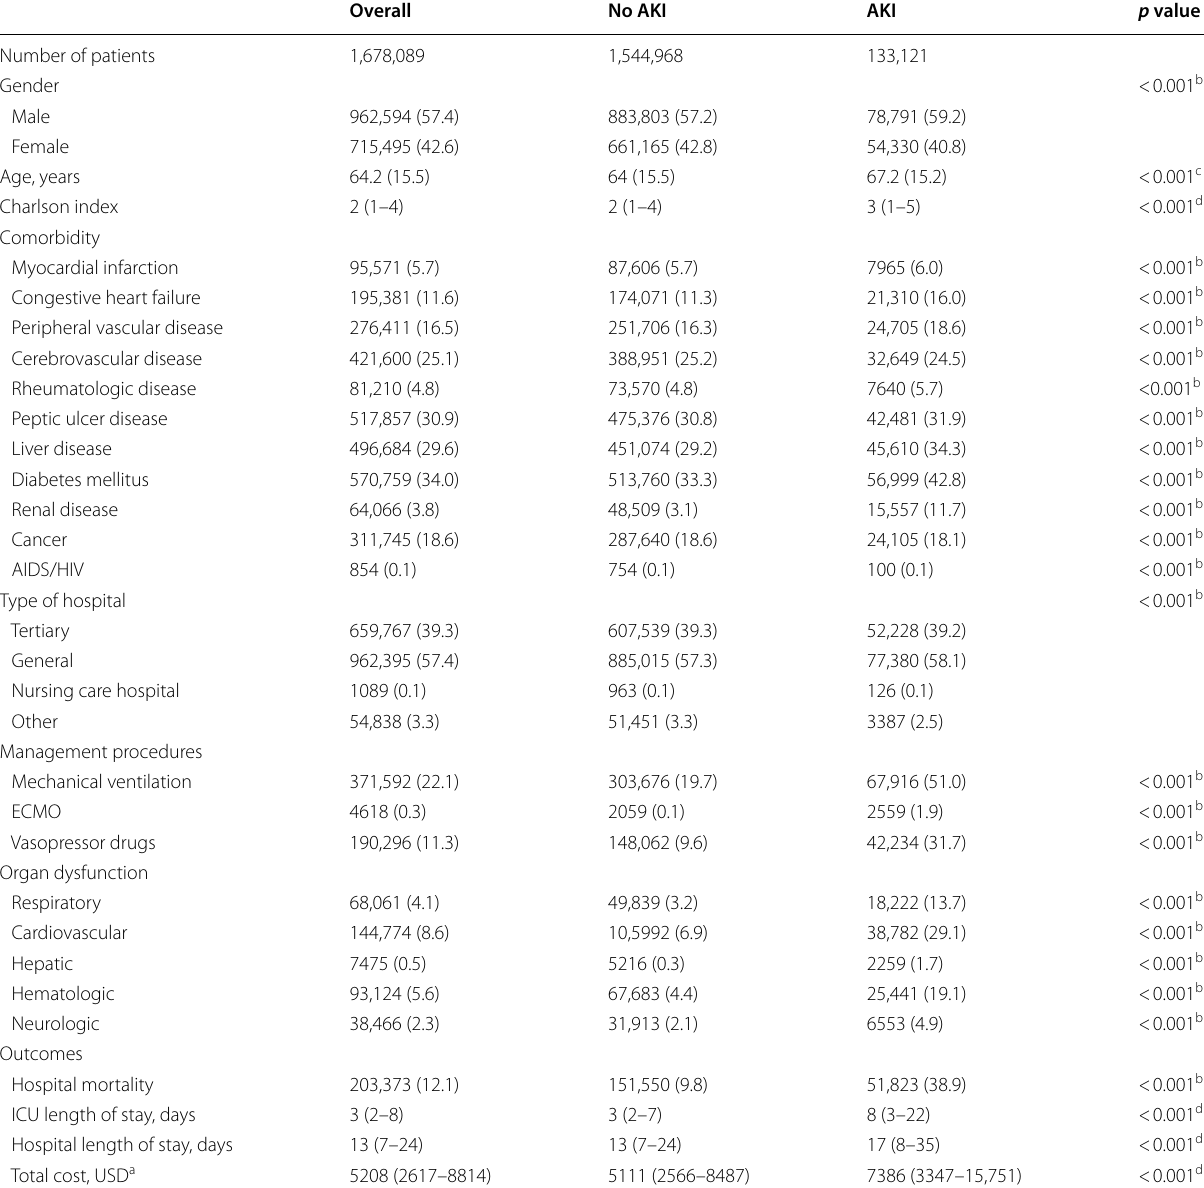
Table 1 Characteristics of critically ill patients by the presence of acute kidney injury in Korea, 2008 to